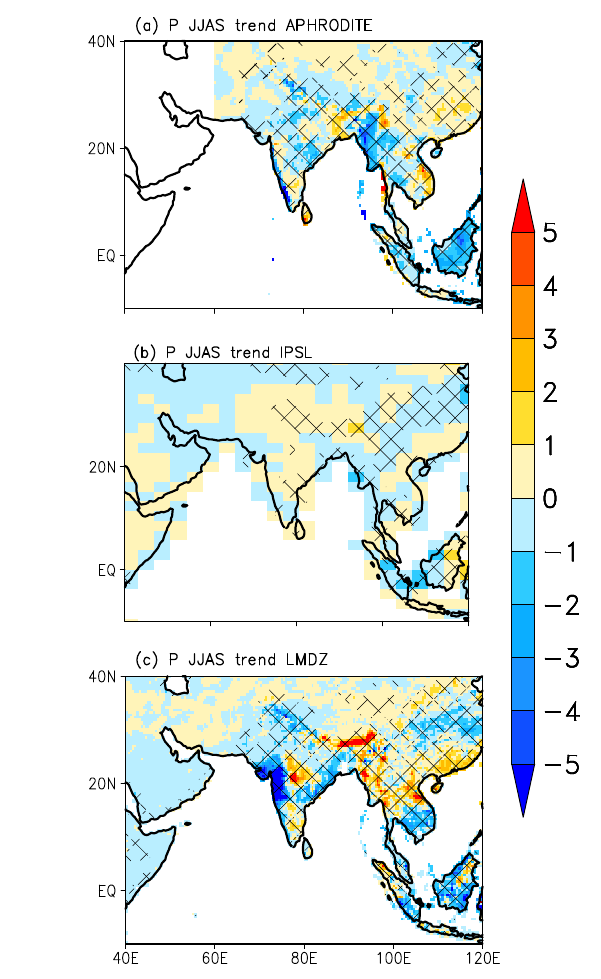
Figure 5. Spatial maps of linear trends in JJAS rainfall based on (a) APHRODITE, (b) IPSL and (c) LMDZ HIST simulation. Units are mmd − 1 change over the period 1951–2005. Trend values ex- ceeding the 95% level of statistical significance based on Student’s t test are hatched.